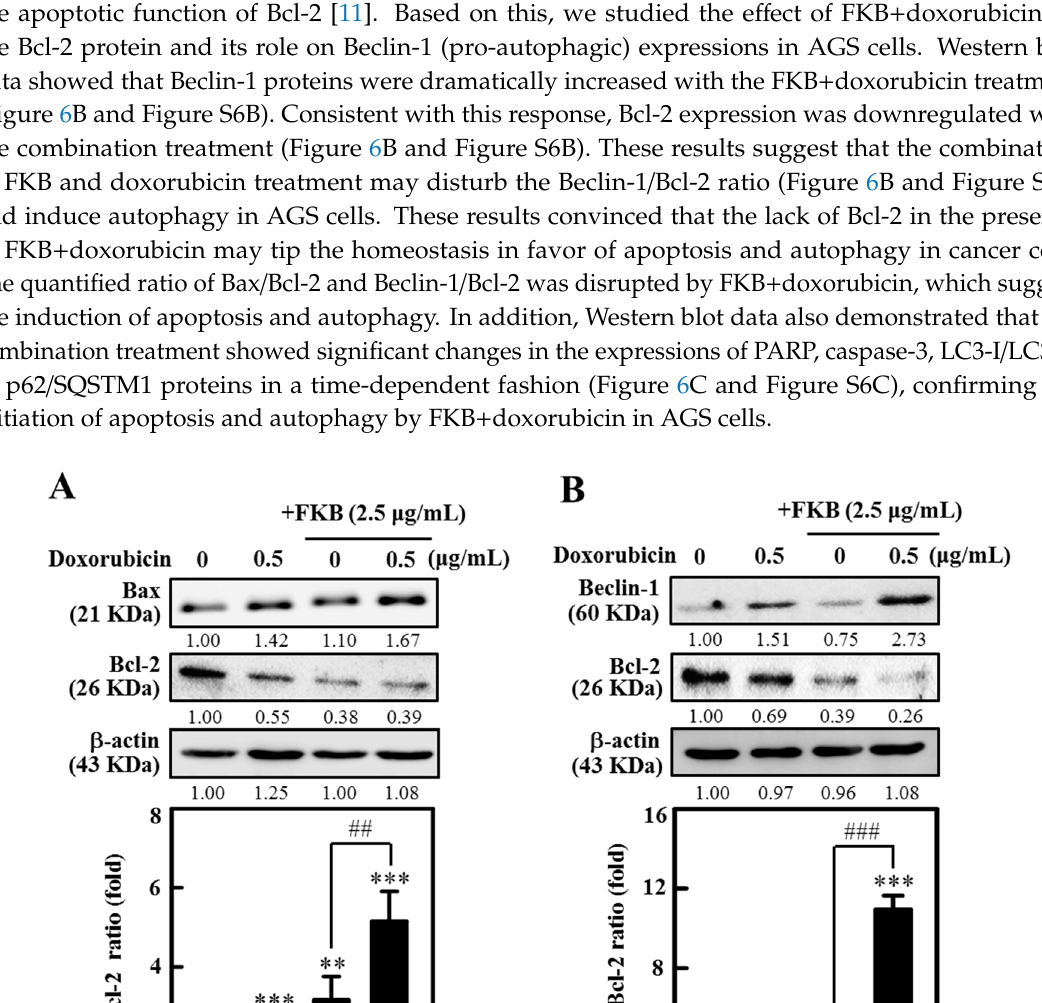
Figure 6. FKB+doxorubicin increased the ratio of AGS cells to Bax/Bcl-2 and Beclin-1/Bcl-2. Cells undergoing a 24-h co-treatment with FKB (2.5 μ g/mL) and doxorubicin (0.5 μ g/mL). ( A ) FKB+doxorubicin increases the ratio Bax/Bcl-2. Western blot determined changes in the proteins Bax and Bcl-2. Relative changes in the Bax/Bcl-2 ratio have been measured using commercially available quantitative software with a control representing 1-fold (Figure S5A). ( B ) The Beclin-1/Bcl-2 ratio increases with FKB+doxorubicin. Western blot determined changes in the Beclin-1 and Bcl-2 proteins expression. Relative changes in the Beclin-1/Bcl-2 ratio were measured by commercially available quantitative software with a control as 1-fold (Figure S5B). ( C ) Time-dependent changes in apoptotic proteins (caspase-3 and PARP) and autophagy markers (LC3-I/LC3-II and p62/SQSTM1), with co- treatment of 0, 1, 3, 6, 12, and 24 h after FKB (2.5 μ g/mL) and doxorubicin (0.5 μ g/mL) (Figure S5C). Values were expressed as mean ± SD ( n = 3). Significant at ** p < 0.01; *** p < 0.001 compared to